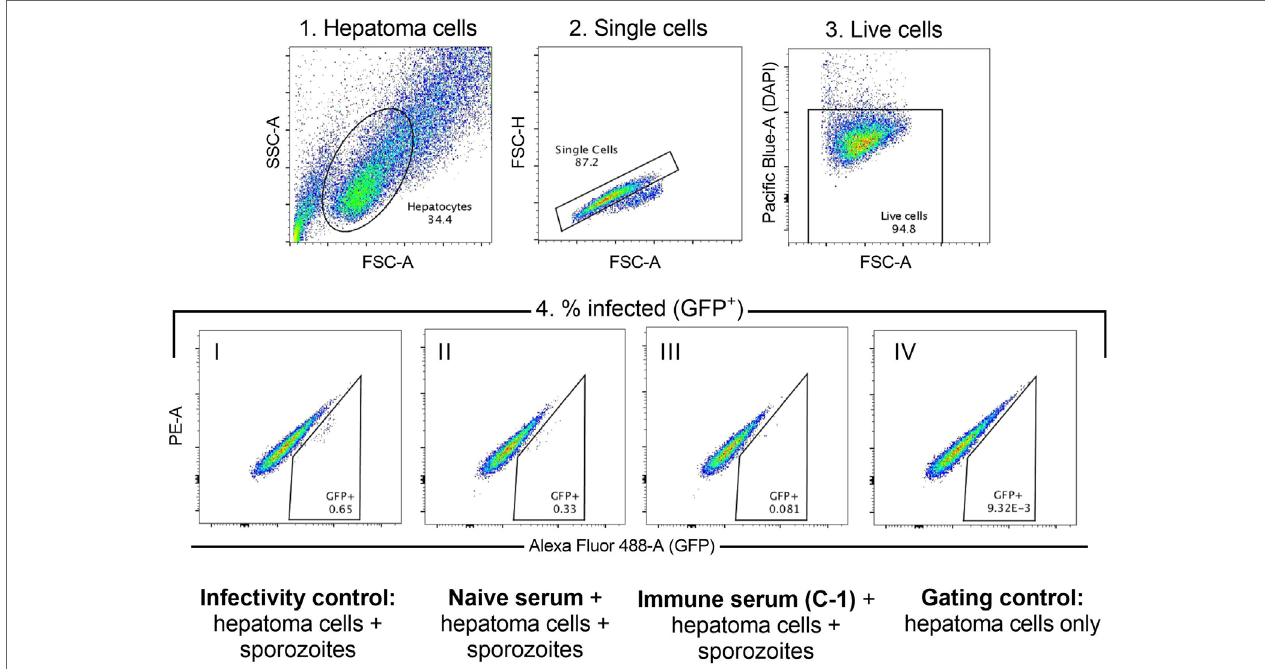
FigUre 2 | Inhibition of sporozoite invasion assay. Hierarchical gating strategy used to determine the percentage of hepatoma cells infected with GFP-expressing sporozoites. 1. Hepatoma cells are gated based on size to exclude debris and large cell clumps. 2. Singlets are gated to exclude smaller cell clumps. 3. Live cells (DAPI-negative) are gated to exclude dead cells. 4. Cells infected with the GFP-expressing sporozoites are GFP + . Cells are gated against both GFP (Alexa Fluor-AF488 channel, GFP + ) and the adjacent channel (PE − ) to exclude signal that is caused by autofluorescence. Representative populations in each of the conditions are shown: I. Infectivity control—sporozoite infection of hepatoma cells in the absence of any serum; II. Sporozoite infection of hepatoma cells in the presence of naïve serum (D0); III. Sporozoite infection of hepatoma cells in the presence of immune serum (C-1); IV. Gating control—hepatoma cells only, no sporozoites or serum